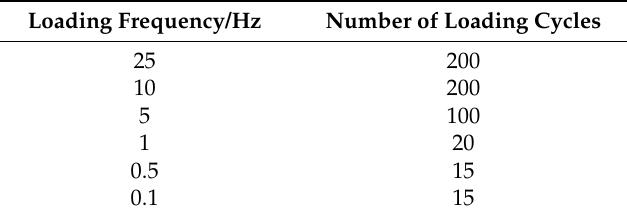
Table 5. The number of loading cycles of DM